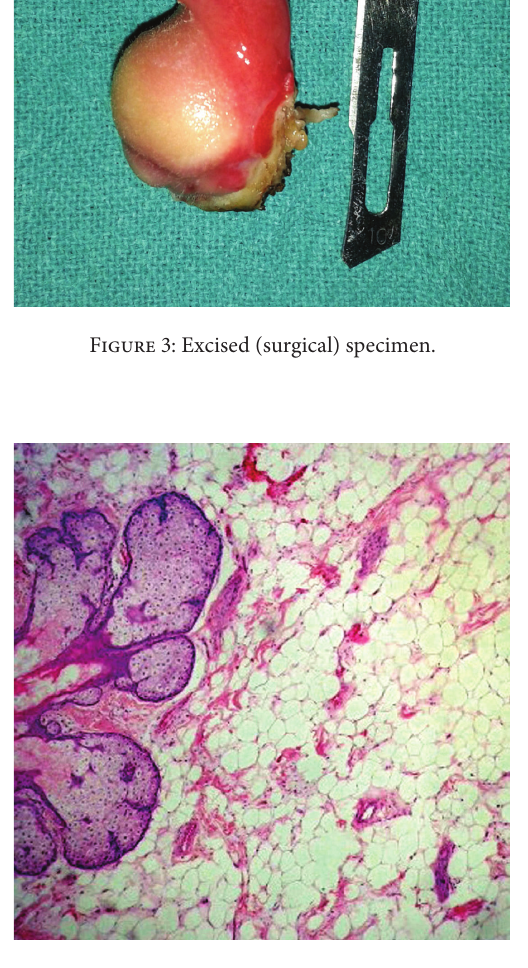
Figure 4: Histopathological examination showing keratinized strat- ified squamous epithelium with sebaceous and sweat glands and matured adipose tissue in the subepithelial